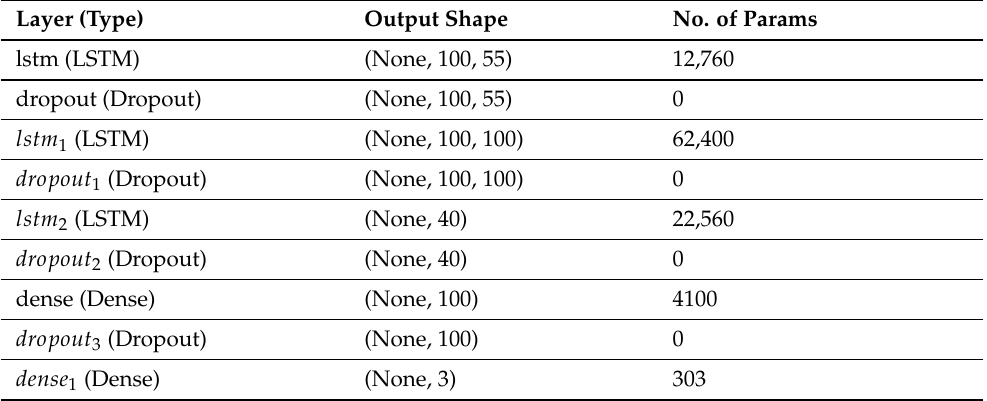
Figure 5. A complete unit architecture of LSTM states. Different activation functions at different cell states are used to retain important information for the next state. Table 2. Summary of the RNN